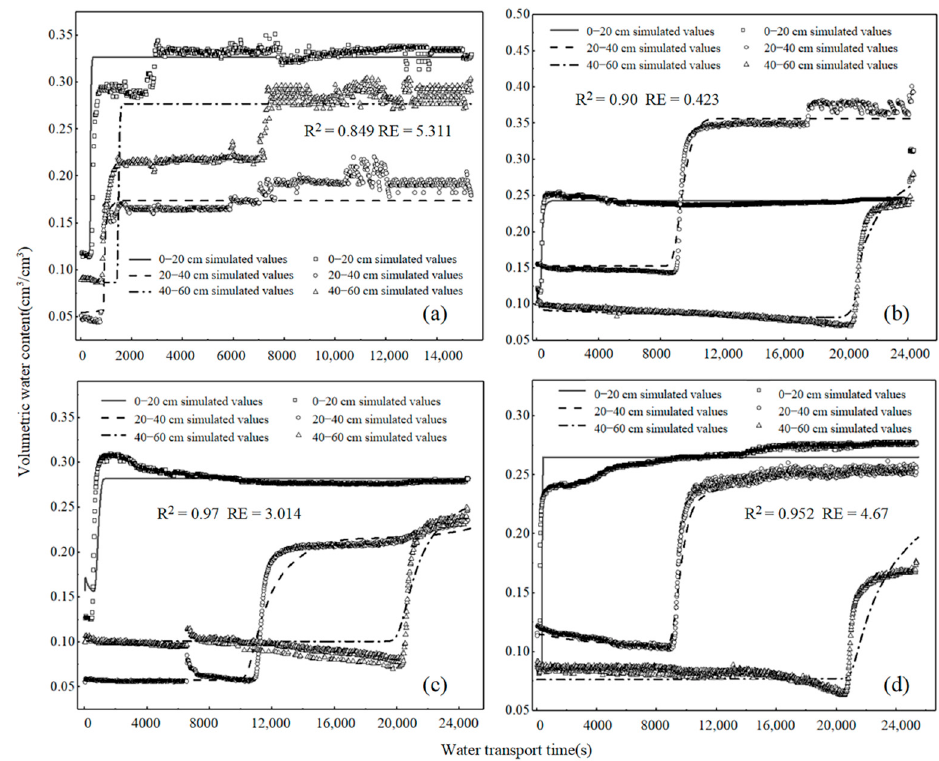
Figure 6. Simulation of water vertical transport in different types of loess ‐ overlaid sandstones. ( a